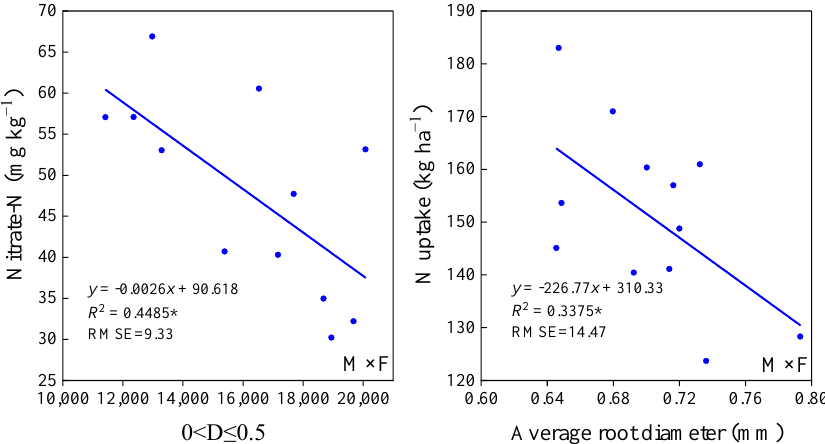
Figure 6. Relationship between fine root at of 0 < D ≤ 0.5, average root diameter of and nitrate-N content, N uptake. * means that there is a significant difference at the level of 0.05.